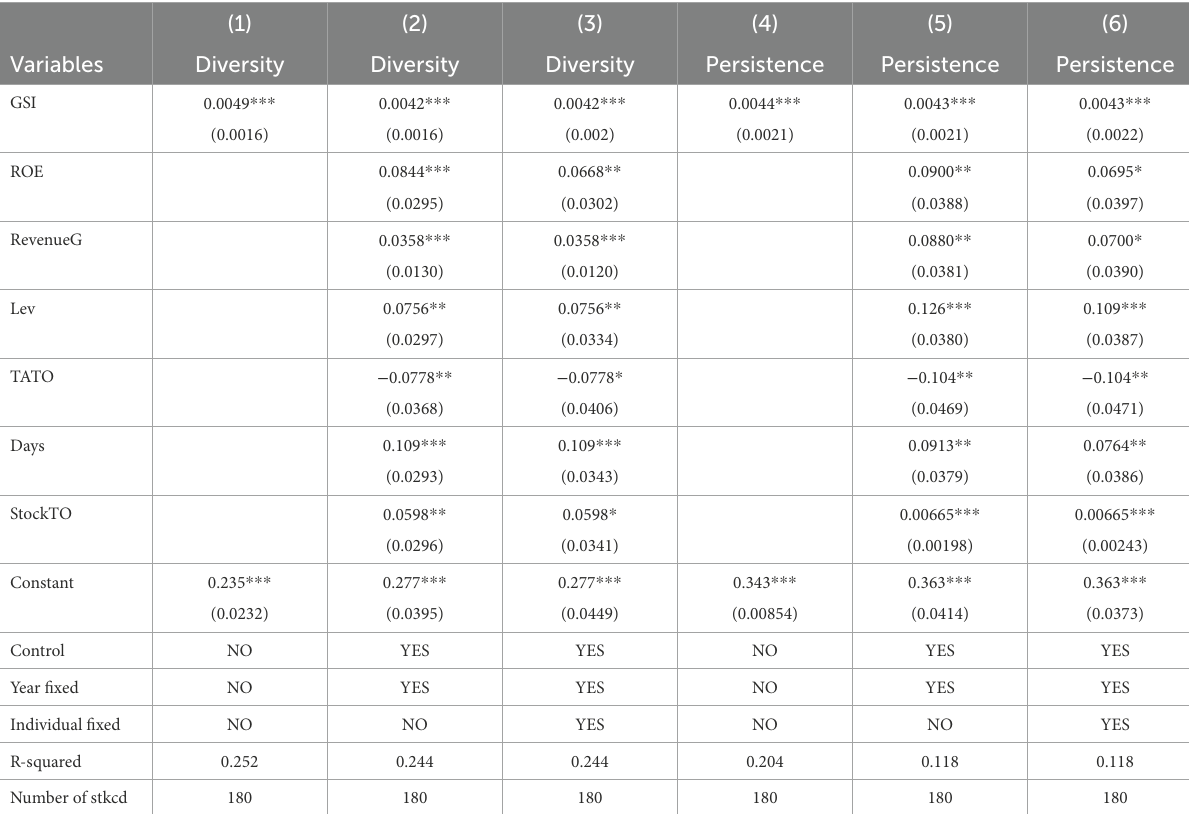
TABLE 2 Empirical results of the impact of GIS on innovation